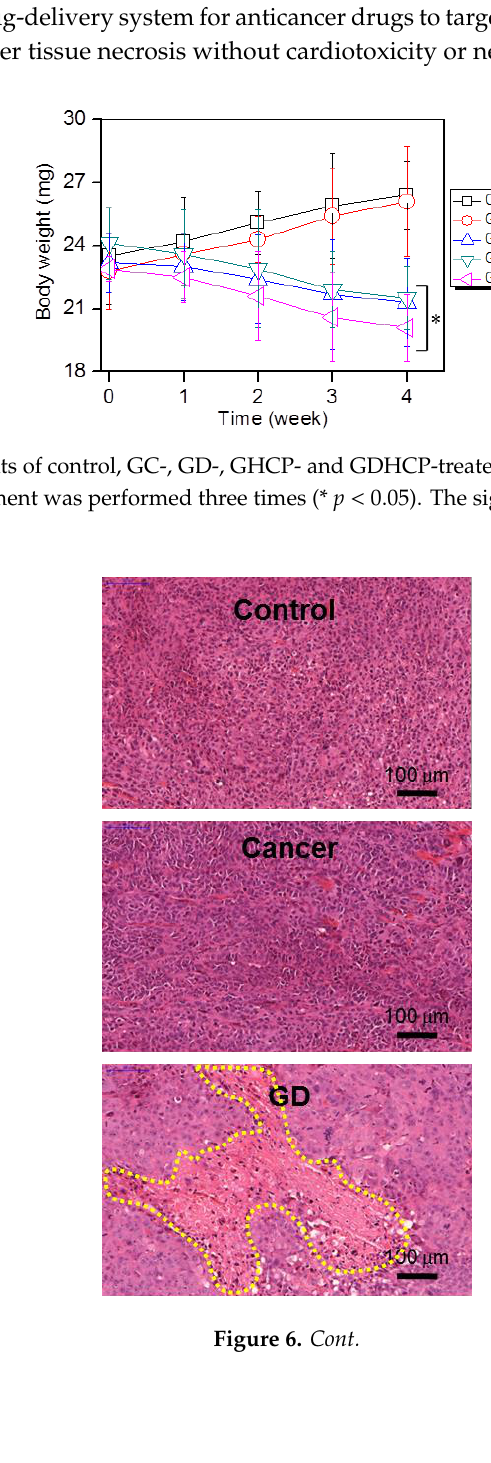
Figure 6. H&E stained slides of cancer tissues extracted from control, cancer bearing, GD-, GHCP- and GDHCP-treated mice after 4 weeks. The slides were observed at 20×. The scale bars indicate 100 µm. The yellow dotted lines indicated necrotic area.